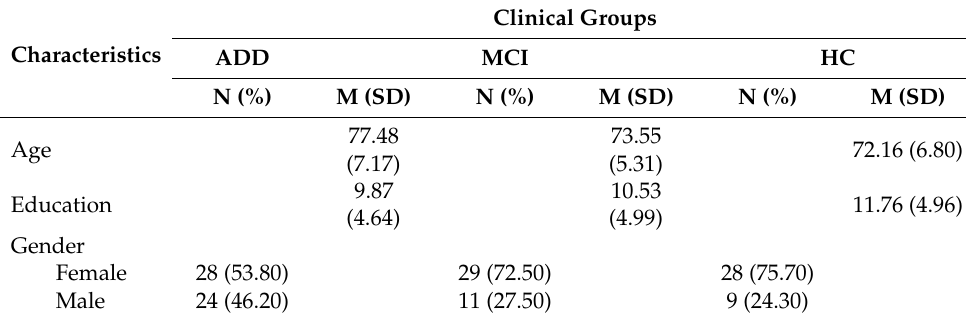
Table 2. Sociodemographic characteristics of the clinical